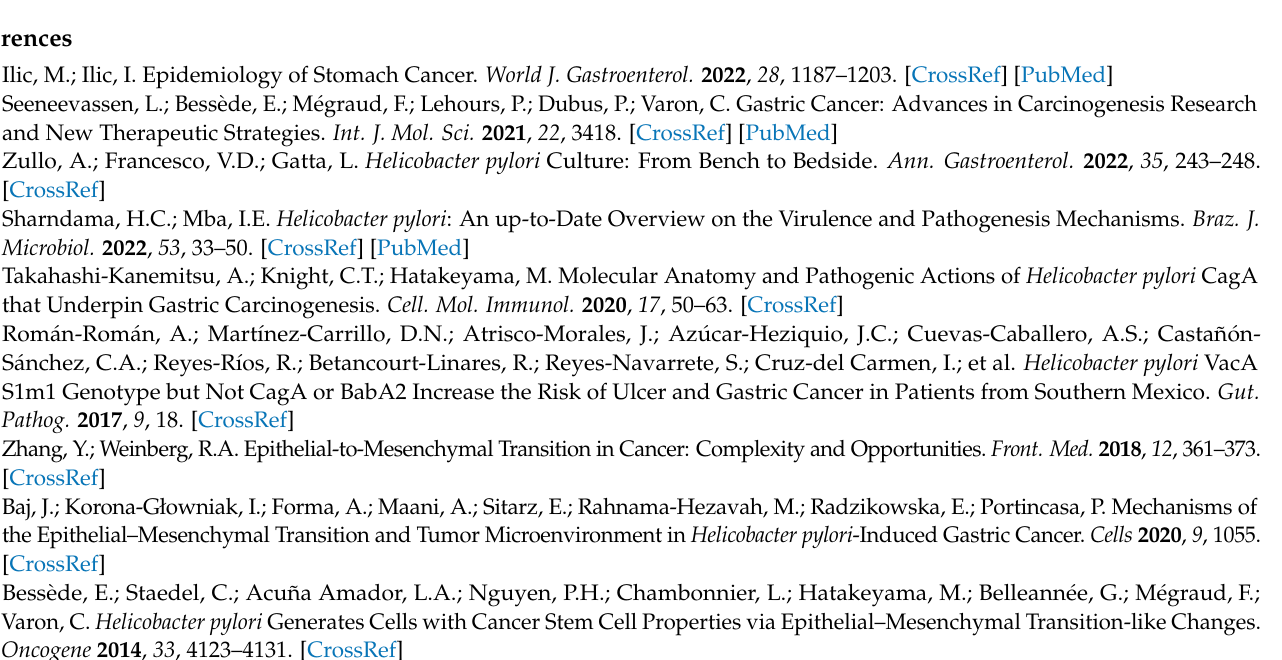
Nrf2-KO vs. WT gastric cell lines. Figure S3: Global proteomics analysis of the gastric non-cancerous cell line (HFE-145). Figure S4: Global proteomics analysis of the diffuse type gastric cancer cell line (AGS). Figure S5: Global proteomics analysis of the intestinal type gastric cancer cell line (MKN74). Figure S6: Immunohistochemistry to detect H. pylori in infected human biopsies. Figure S7: Raw blot of the western-blot presented in Figure 1. Table S1: Total proteome of non-cancerous HFE-145, diffuse type of GC AGS and intestinal type of GC MKN74 cells expressing or not expressing Nrf2; File S1: Supplementary material and methods